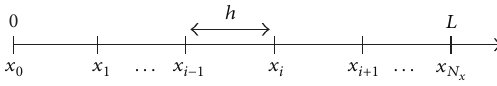
Figure 1: Uniform grid with a spatial step size ℎ